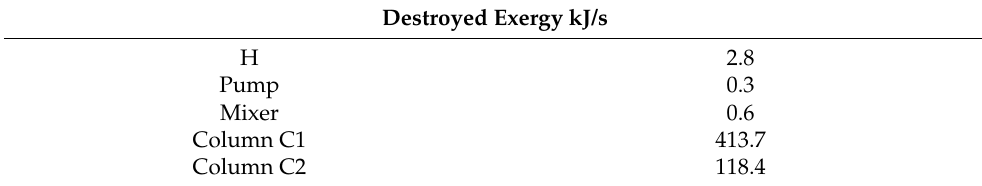
Table 3. Destroyed exergy in each operation.